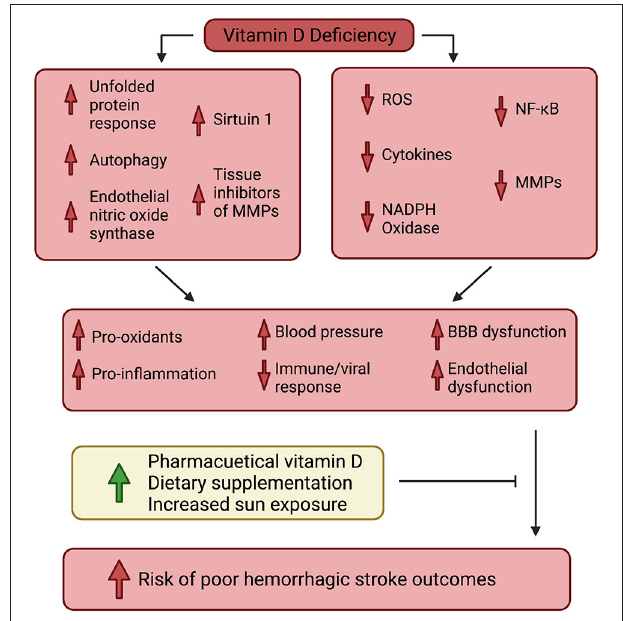
FIGURE 1 | Visual schematic representing the dynamics of vitamin D’s impact on hemorrhagic stroke patient health.